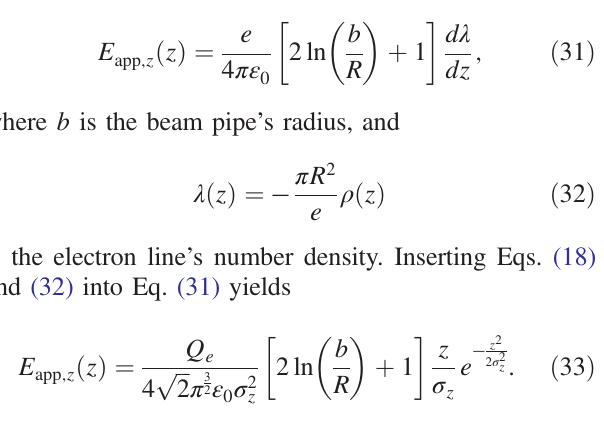
FIG. 9. Influences of the longitudinal space charge field on the Fourier components of the longitudinal density modulation at the FEL resonant wavelength as a function of longitudinal location along the electron bunch. The ion is at rest, and the parameters from the proof of the CeC principle experiment are applied in generating these plots. The abscissa is the longitudinal location in units of rms bunch length. (a) The relative change in percentage of the amplitude of the Fourier component calculated from Eq. (28); (b) the phase change of Fourier component in degrees, calculated from Eq.